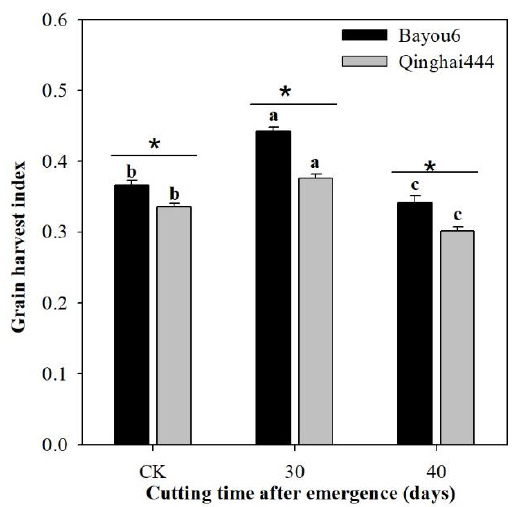
Figure 8. Grain harvest indexes for the two oat species (Bayou6 and Qinghai444) among varying cutting times after emergence. * indicates significant difference ( p < 0.05) between Bayou6 and Qinghai444 under the same treatment. Significant differences are shown by different lowercase letters under cutting stage in each oat cultivar at p < 0.05. CK is control that was harvested without cutting. Data are means ± SE ( n = 4).